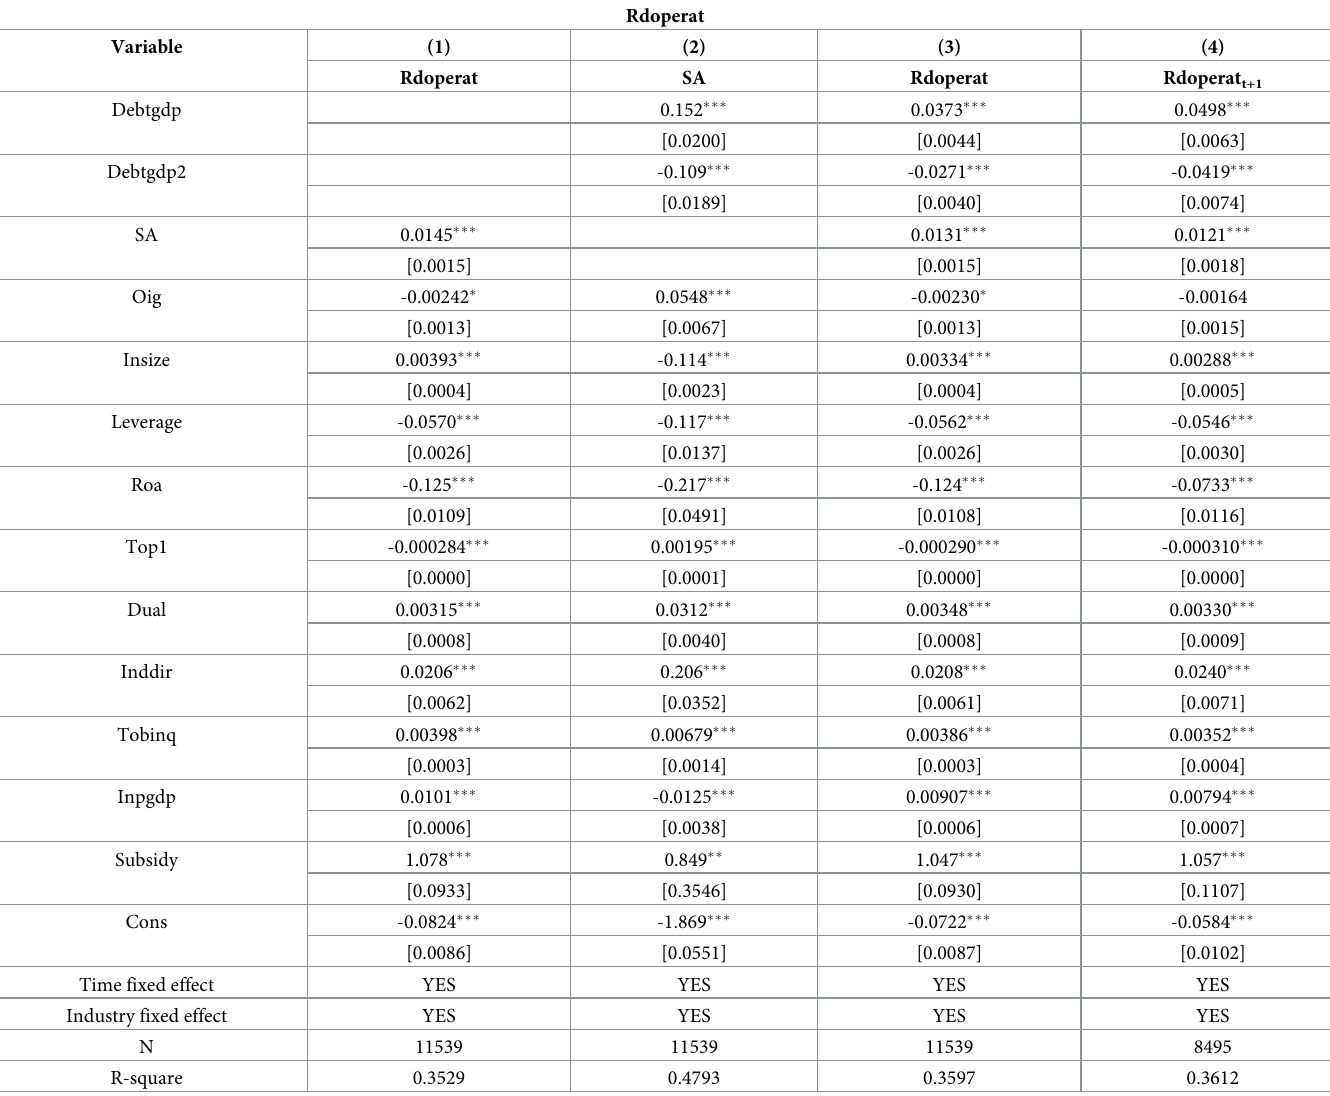
Table 7. Regression results of financing constraint as the mediating